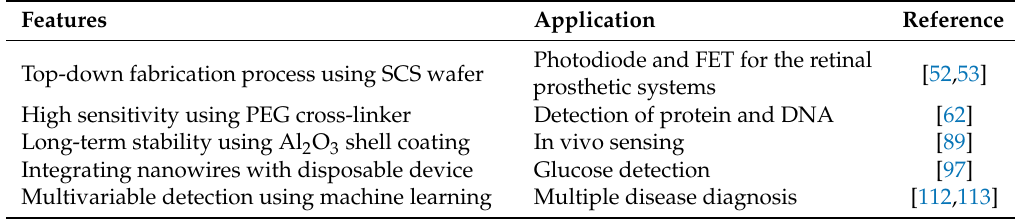
Table 1. Summary of the salient features and the target application of nanowire-based biosensors.